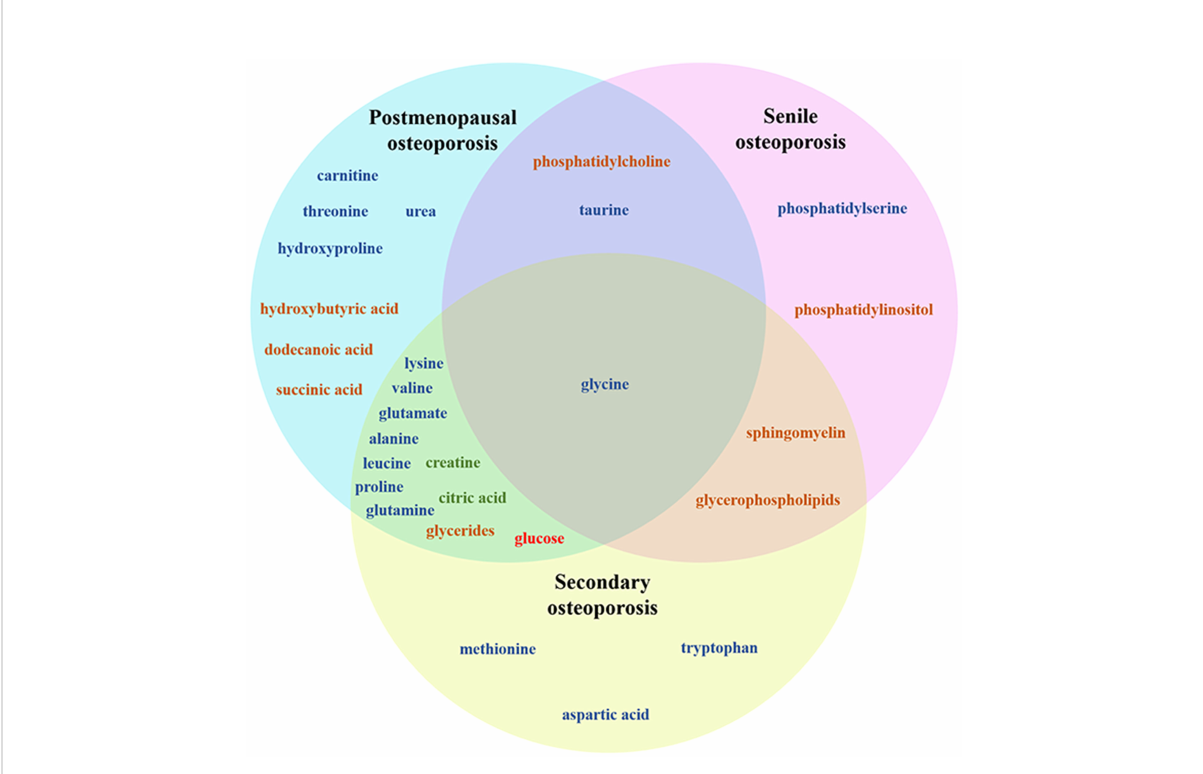
FIGURE 1 Venn diagram of metabolite changes in different types of OP pathogenesis. Dark blue: Amino acid metabolism product, dark yellow: Lipid metabolism product, dark green: Energy metabolism product, red: sugar